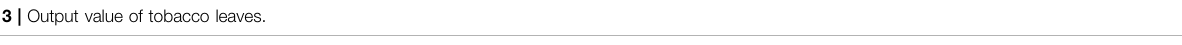
TABLE 3 | Output value of tobacco leaves.